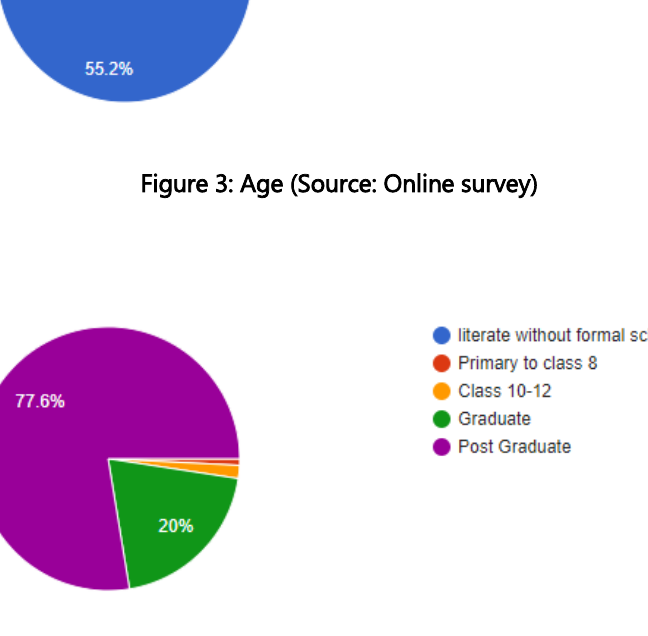
Figure 4: Educational Qualification (Source: Online